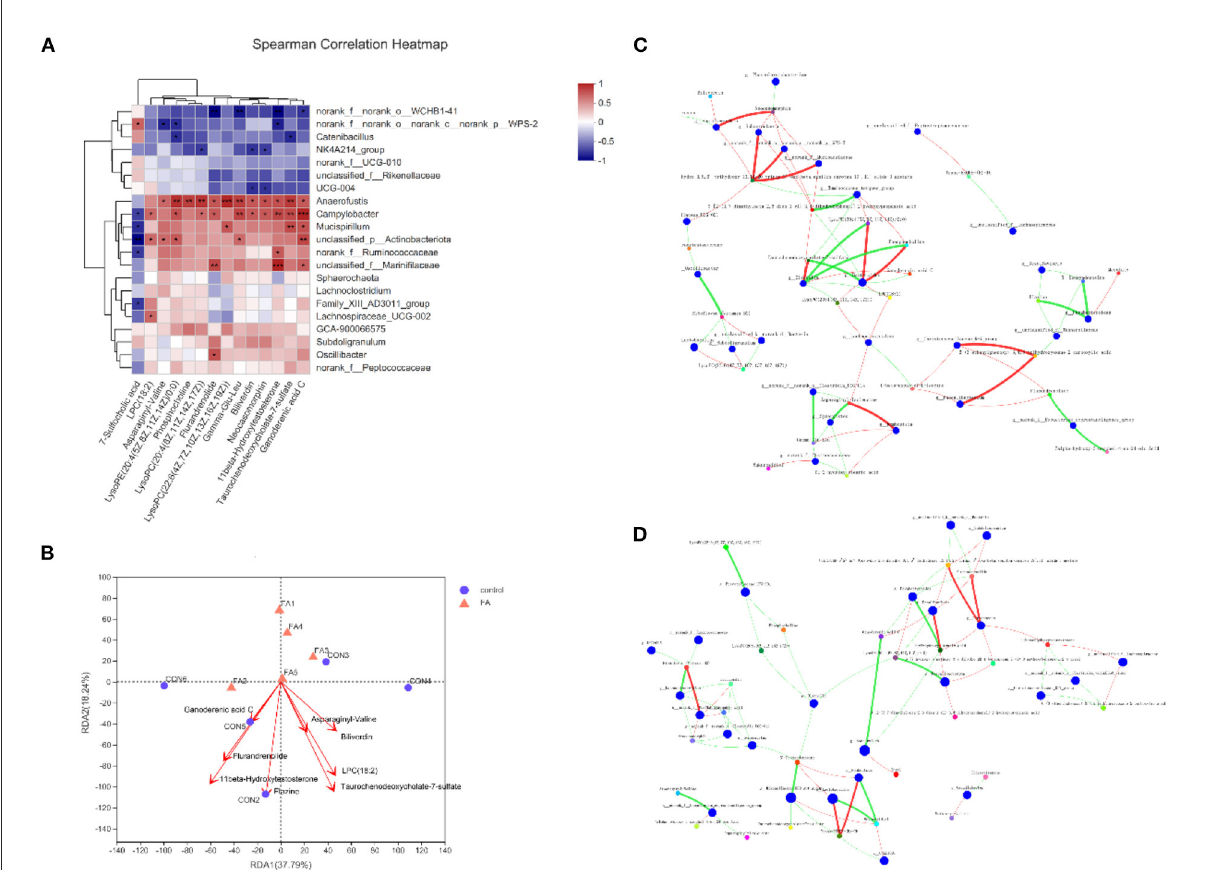
FIGURE5 Correlation of gut metabolites and microbiota between FA-H and control group. (A) Heat map of correlation between differential metabolites and microbiota based on Spearman’s correlation analysis. * P < 0.05, ** P < 0.01, *** P < 0.001. (B) RDA plot showing the correlation between microbial community composition and metabolites. (C) Bivariate correlation analysis of microbiota and metabolites in FA-H group. (D) Bivariate correlation analysis of microbiota and metabolites in control. A connection represents a strong (Spearman’s correlation coefficient [ ρ ] > 0.5) and significant ( P < 0.01) correlation. Red indicates positive correlation, whereas green indicates negative correlation. The size of each node represents the relative abundance of the